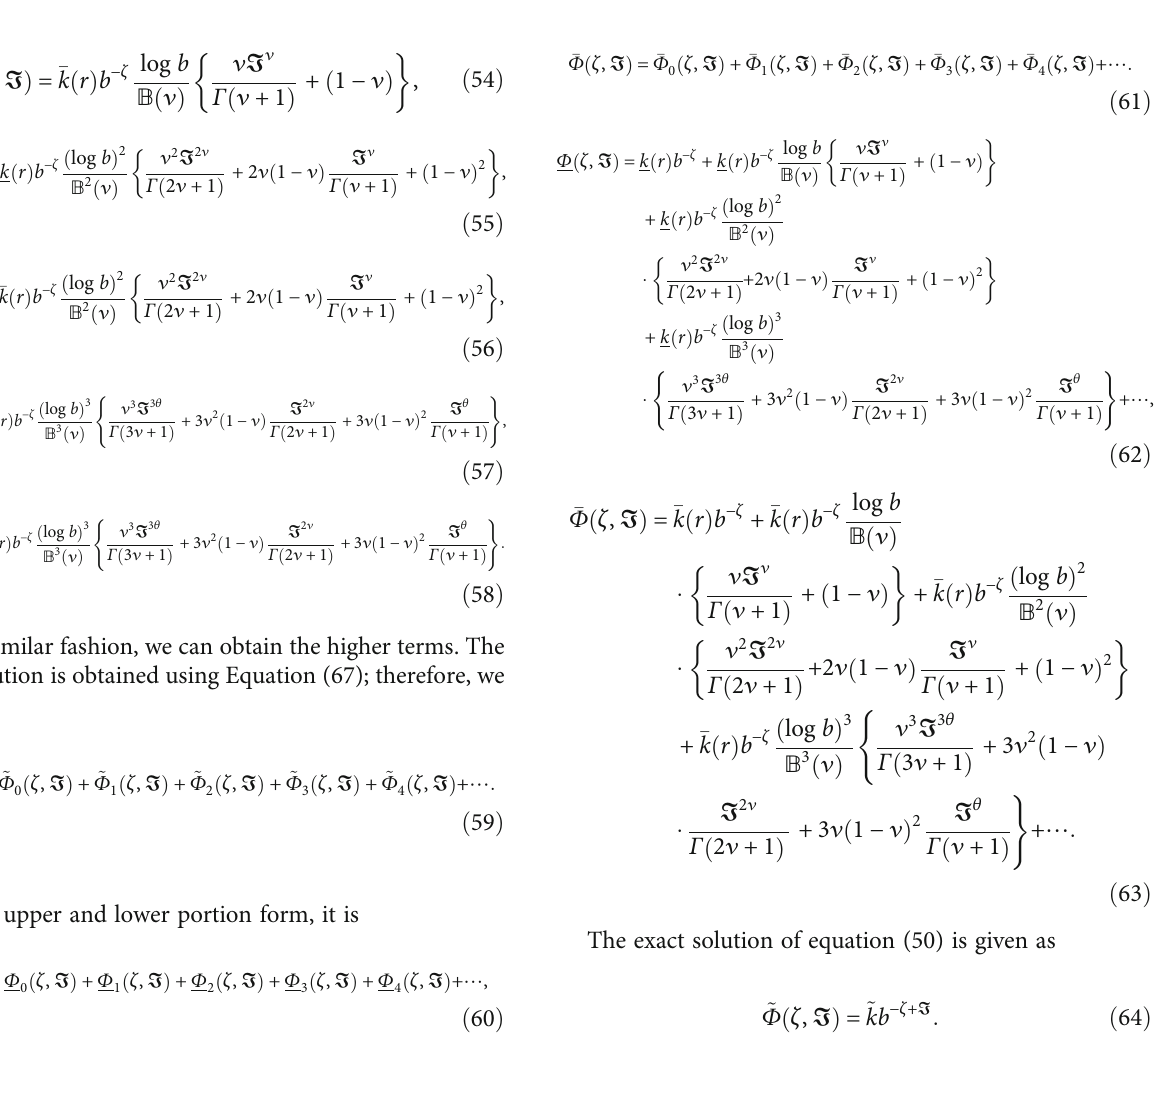
Figure 2: First graph shows the two-dimensional fuzzy lower and upper branch graph of analytical series solution and second graph the di ff erent fractional-order of ν